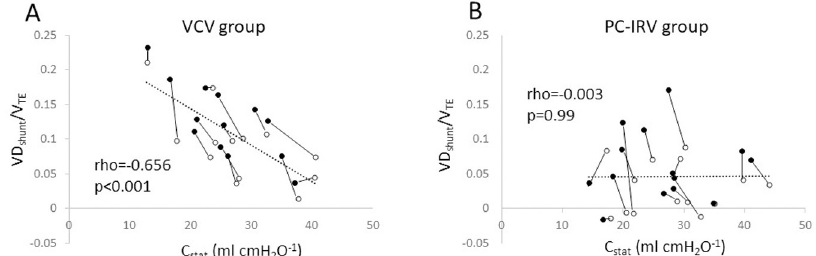
Fig 3. Correlation between static compliance and shunt dead space ratio (shunt dead space/expired tidal volume). The correlation between static compliance and shunt dead space ratio was evaluated using Spearman’s rank correlation at T 20min (open circle) and T 2h (closed circle) in the volume-controlled ventilation (A) and pressure-controlled inverse ratio ventilation (B) groups.